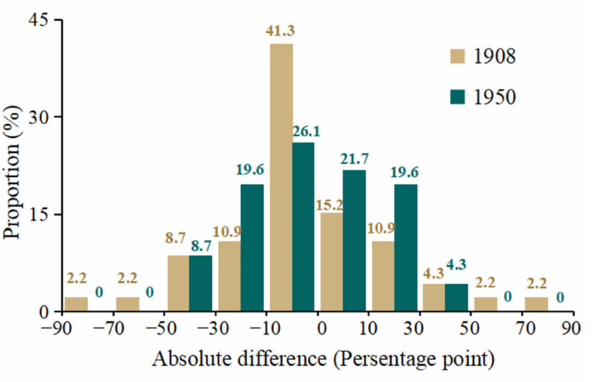
Figure 10. Absolute differences in county-level cropland fractions obtained by Ye et al. [48] and in this